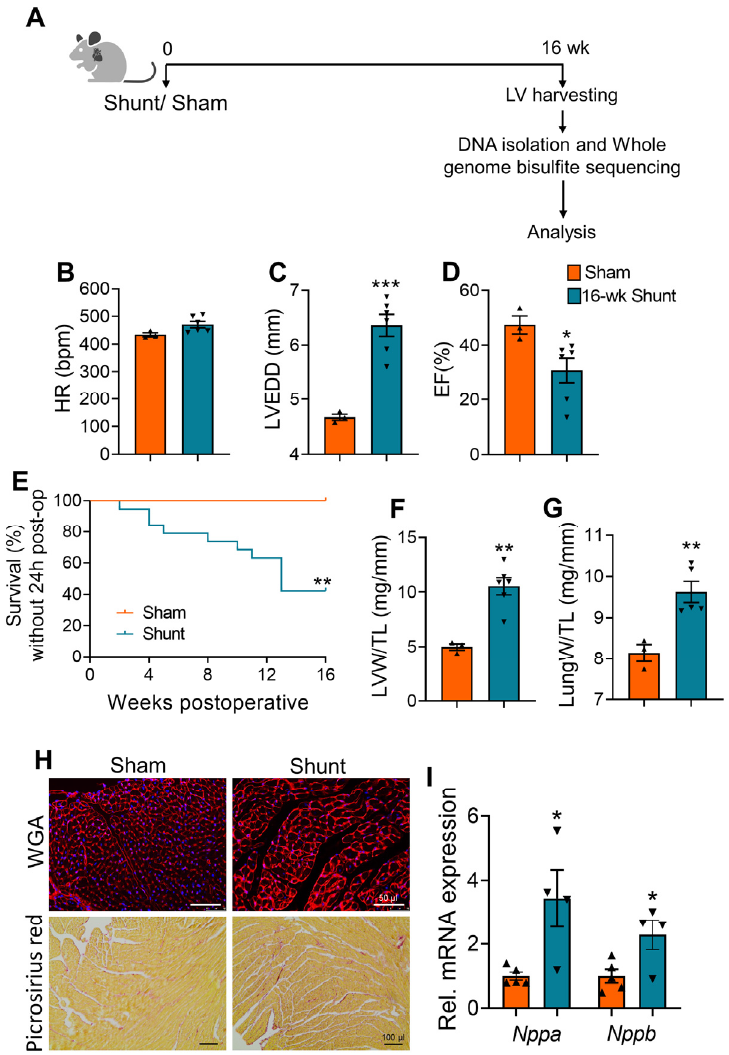
Figure 1. Long-term VO (16 weeks post-shunt) resulted in pathological cardiac remodeling and HF progression. ( A ) Workflow for DNA methylation analysis in VO mice. ( B – D ) Echocardiographic parameters: HR, heart rate ( B ); LVEDD, LV end-diastolic diameter ( C ); EF, ejection fraction ( D ). ( E ) Kaplan–Meier survival analysis, log-rank test, n = 9 sham and 19 shunt mice. ( F , G ) Morphometric parameters: LVW/TL, LV weight-to-tibia length ( F ); LungW/TL, lung weight-to-tibia length ( G ). ( H ) Representative images of WGA- (upper panels) and picrosirius red- (lower panels) stained myocardial cross-sections. ( I ) Quantitative real time PCR analysis for the expression of fetal cardiac stress genes. Values are mean ± SEM, n = 3–6 hearts/group. * p < 0.05, ** p < 0.01, *** p < 0.001 vs. sham, two-tailed unpaired Student’s t -test .